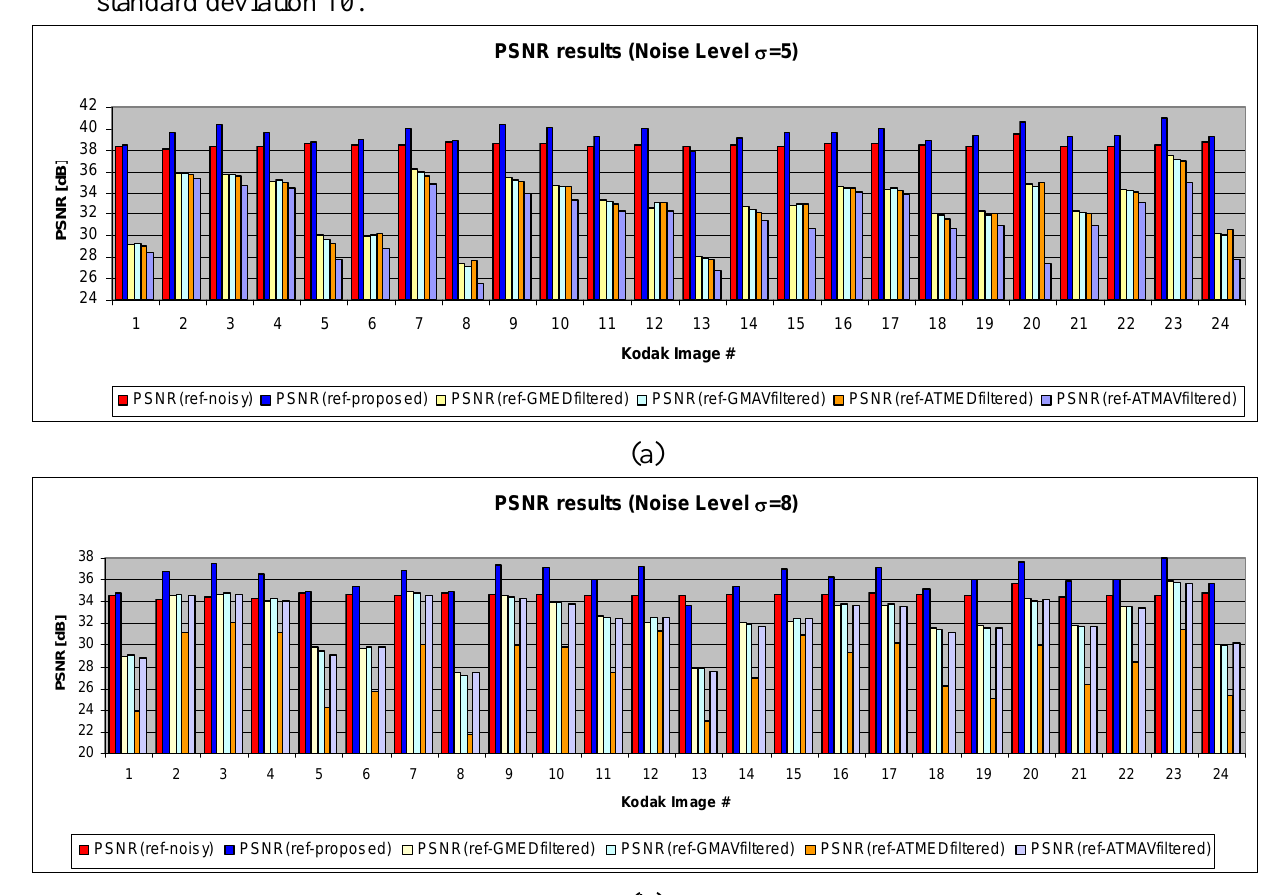
Figure 21. PSNR comparison between proposed solution and other fuzzy approaches for the Standard Kodak Images test set. (a) Kodak noisy images set with standard deviation 5. (b) Kodak noisy images set with standard deviation 8. (c) Kodak noisy images set with standard deviation